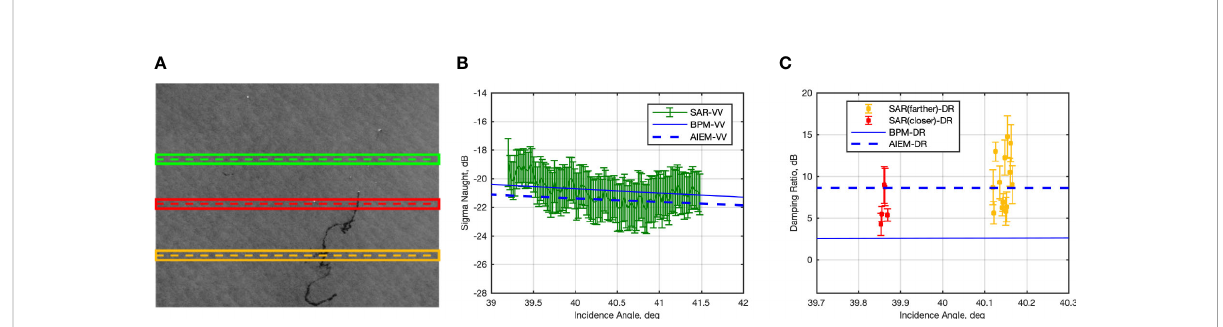
FIGURE 6 Experiments related to the TSX SAR scene acquired on August 17, 2011, at high incidence angle (about 40°), see Table 1 (A) Excerpt of the VV- polarized speckle- fi ltered SAR scene. The slick-free ROI (green box) and the two oil slick-covered ROIs (red and orange boxes) used for quantitative analysis are also annotated. (B) The VV-polarized NRCS measured over the slick-free ROI is contrasted with the BPM and AIEM predicted one. (C) The measured DR related to red and orange oil-covered ROIs contrasted with BMP and AIEM